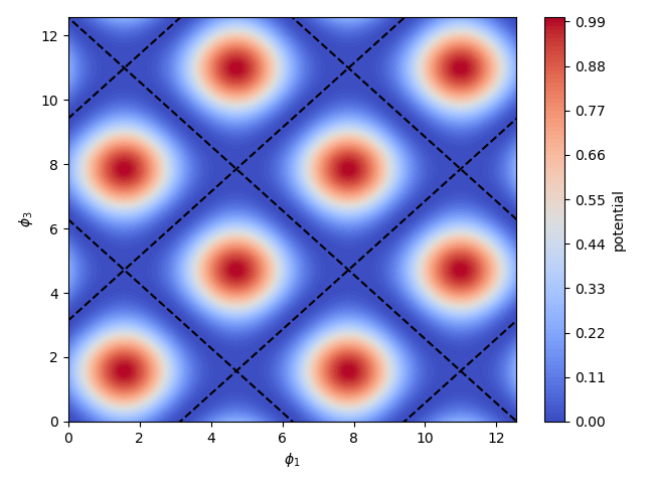
Figure 11. The potential U ( (cid:30) 1 ; (cid:30) 3 ) = 1 (sin (cid:30) 1 + sin (cid:30) 3 ) 2 , restricted to a plane (cid:30) 2 = (2 n + 1) (cid:25) , 4 n 2 Z . The vacua lines (cid:30) 3 = (cid:30) 1 + (2 n + 1) (cid:25) , and (cid:30) 3 = (cid:0) (cid:30) 1 + 2 n(cid:25) , n 2 Z are